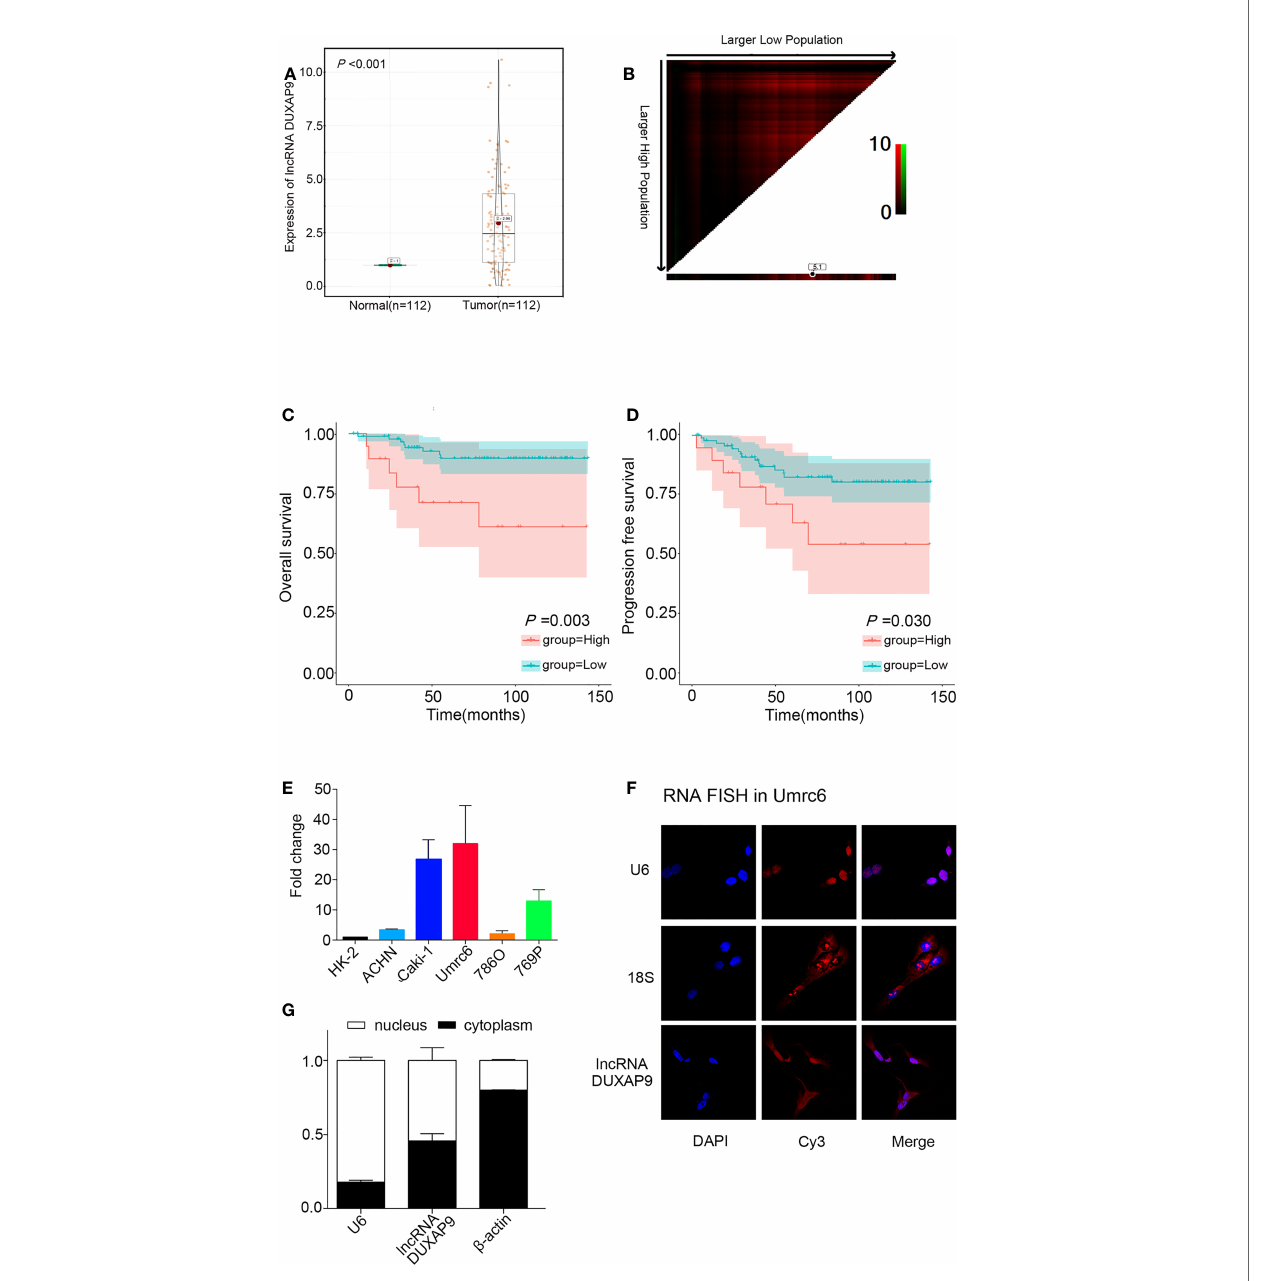
FIGURE 1 | DUXAP9 was upregulated in renal cancer and predicted poor prognosis in localized ccRCC patients. (A) Relative DUXAP9 expression levels in 112 pairs of localized ccRCC and matched adjacent non-tumor tissues from the SYSUCC Biobank, as detected by qRT-PCR. (B) Optimal cutoff to divide ccRCC patients into high and low DUXAP9 expression groups, as determined by X-tile bioinformatics software based on the integral optic density. (C, D) Kaplan – Meier curves showing that high DUXAP9 expression (n=19) in localized ccRCC tissues was signi fi cantly associated with poor OS and PFS rates, compared with low expression (n=93). (E) Relative DUXAP9 expression levels in renal cancer cell lines, as detected by qRT-PCR. (F) FISH analysis of the subcellular distribution of DUXAP9 in Umrc6. (G) Subcellular fractionation and qRT-PCR analyses of DUXAP9 expression in the nucleus and cytoplasm. Data represent mean ± SD from three independent experiments. ccRCC, clear cell renal cell carcinoma; qRT-PCR, quantitative real-time PCR; OS, overall survival; PFS, progression-free survival; FISH, fl uorescence in situ